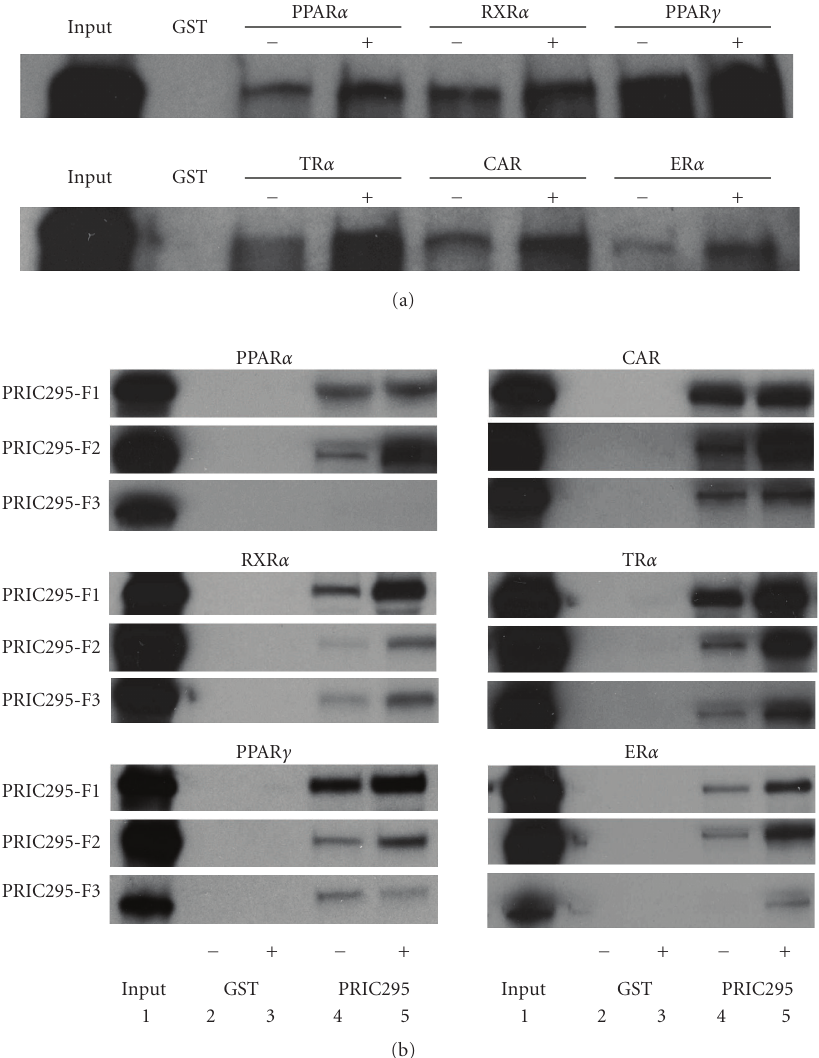
Figure 4: PRIC295 interactions with nuclear receptors. (a) In vitro interaction of radiolabeled full-length PRIC295 with nuclear receptors PPAR α , RXR α , PPAR γ , TR α , CAR, and ER α . PRIC295 was radiolabeled using 35 S-methionine (Perkin Elmer) and incubated with each shown receptor fusion protein in GST-pulldown assay. ( − ) minus indicates in vitro binding interaction in the absence of cognate ligand and (+) plus indicates the presence of receptor-specific ligand during the in vitro binding interaction. Ligands used: Wy-14,643 for PPAR α ; 9-cis-retinoic acid for RXR α ; rosiglitazone for PPAR γ ; triiodothyronine (T3)TR α ; 1,4-Bis[2-(3,5-dichloropyridyloxy)]benzene (TCPOBOP) for CAR; 17- β -estradiol for ER α . All ligands were used at a concentration of 100 μ M. (b) Interaction of radiolabeled PRIC295 fragments Δ PRIC295 1–915 (F1), Δ PRIC295 840–1815 (F2), and Δ PRIC295 1740–2671 (F3) with GST-fusion nuclear receptor proteins. Loading for each lane is indicated at the base of each panel. Lane 1 input; lane 2 GST alone without ligand; lane 3 GST alone with receptor-specific ligand; lane 4 GST-receptor fusion in the absence ligand; lane 5 in the presence of receptor-specific ligand. All ligands used are as previously described in